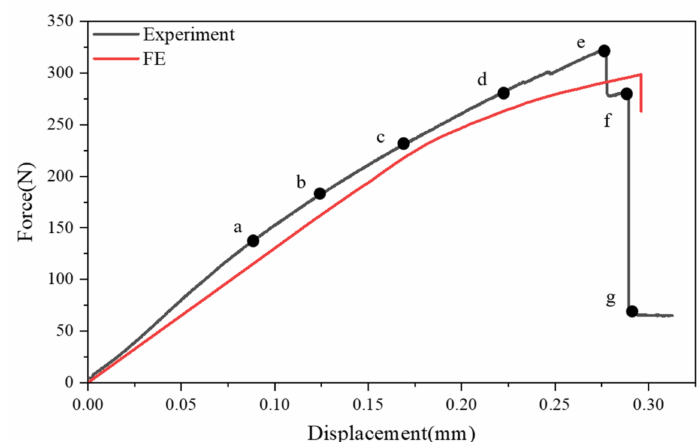
Figure 8. Experimental and numerical force–displacement curves.